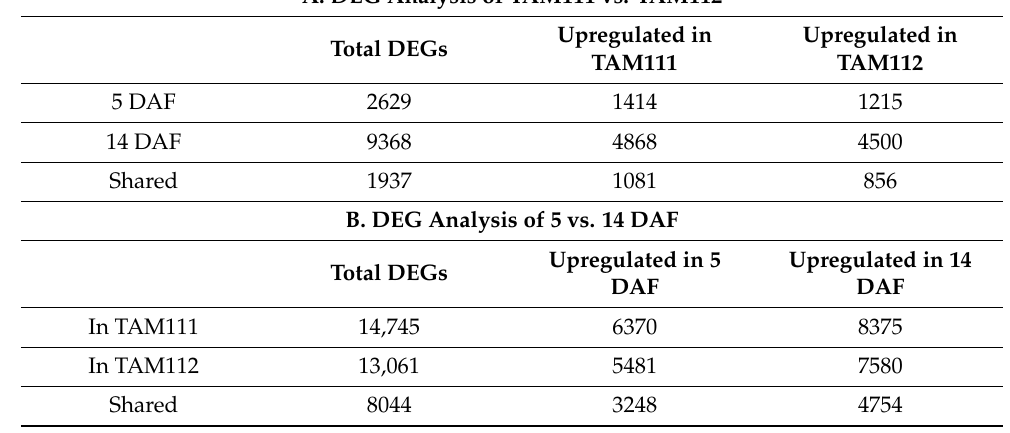
Table 1. DEG statistics of TAM111 vs. TAM112 ( A ) and 5 DAF vs. 14 DAF ( B ). DEGs were identified using the criteria | − log 2 | > 1, and Adj. p < 0.01. The numbers indicate the number of genes identified. Shared row indicates the numbers of identical DEGs between the two time points (top) or the cultivars